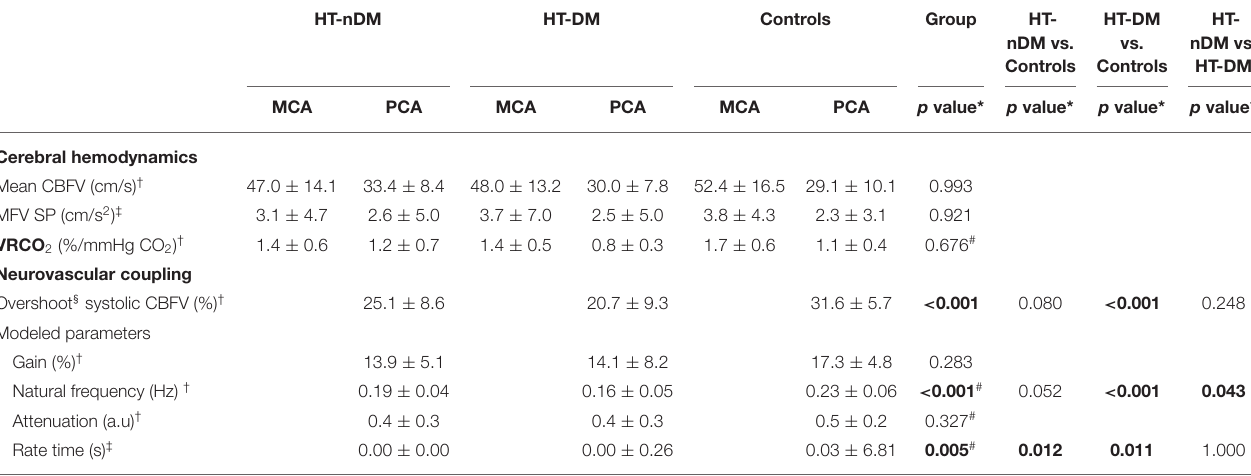
* Two-factor mixed-design ANOVA for the interaction between group variable (HT-DM vs. HT-nDM vs. controls) and arterial territory (MCA vs. PCA), controlling for age and gender, with Bonferroni post-hoc. For NVC, values were obtained using an ANCOVA. Effect size: rate time η p ² = 0.174, natural frequency η p ² = 0.313 and overshoot systolic CBFV η p ² = 0.22. † Values are presented as mean ± standard deviation. ‡ Values are presented as median ± interquartile range. § Maximal CBFV increase during visual stimulation. || gender significantly interfered with the model. # age significantly interfered with the model. a.u., arbitrary units; CBFV, cerebral blood flow velocity; HT-DM, hypertensive diabetic; HT-nDM, hypertensive non- diabetic; MCA, middle cerebral artery; MFV SP, median flow velocity spectral power; PCA, posterior cerebral artery; VRCO 2 , vasoreactivity to carbon dioxide. Bold values of statistically significant p values (p <